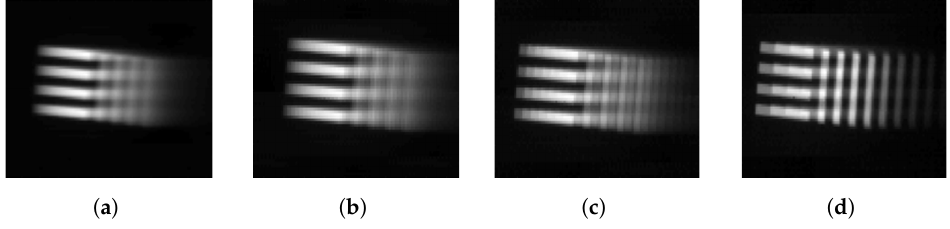
Figure 5. Examples of stepping effects. ( a ) Shifting one pixel between adjacent frames, ( b ) Shifting two pixels between adjacent frames, ( c ) Shifting four pixels between adjacent frames, ( d ) Shifting eight pixels between adjacent frames.